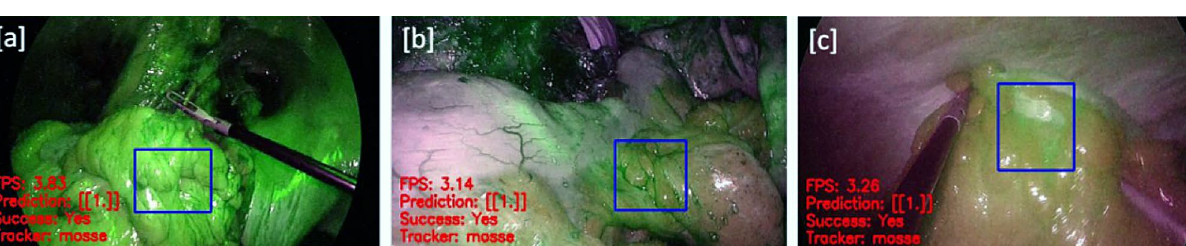
Figure 6. Online validation: Frames characterized by different brightness levels acquired directly from the endoscope during the online validation: ( a ) is characterized by high brightness, ( b ) by medium brightness, and ( c ) by low brightness. Nevertheless, the real-time prediction works even in a low brightness